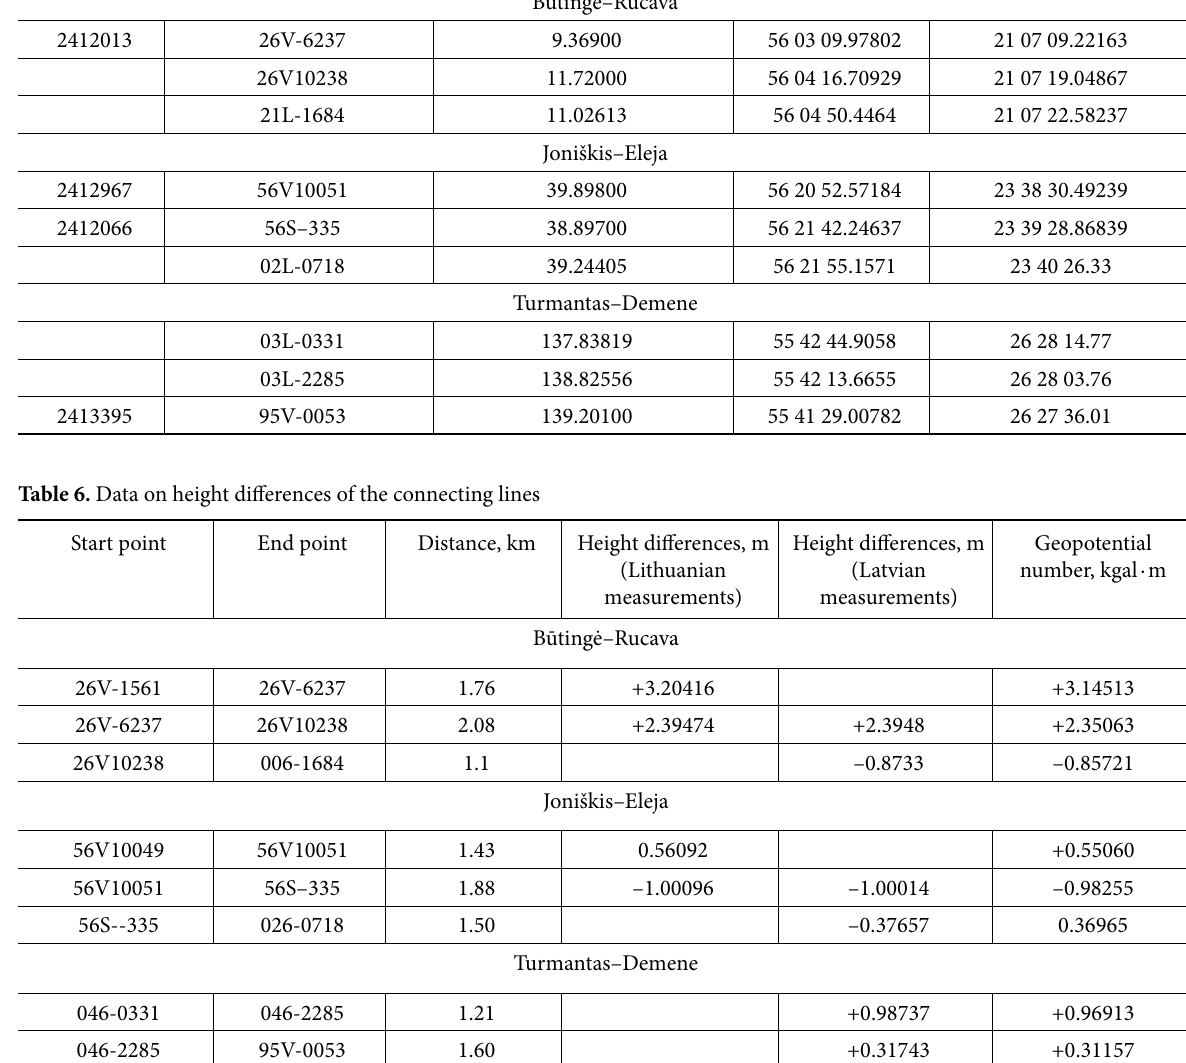
Table 5. Data on benchmarks of connecting levelling lines UELN code